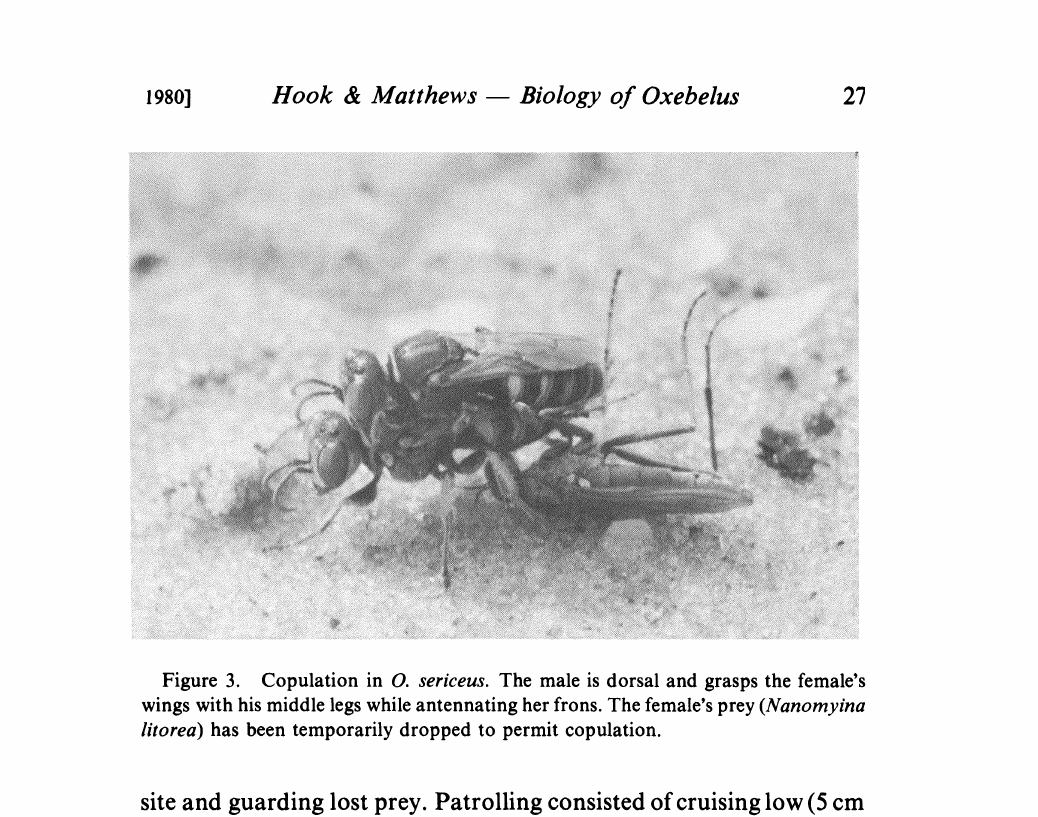
Figure 3. Copulation in O. sericeus. The male is dorsal and grasps the female’s wings with his middle legs while antennating her frons. The female’s prey (Nanomyina litorea) has been temporarily dropped to permit